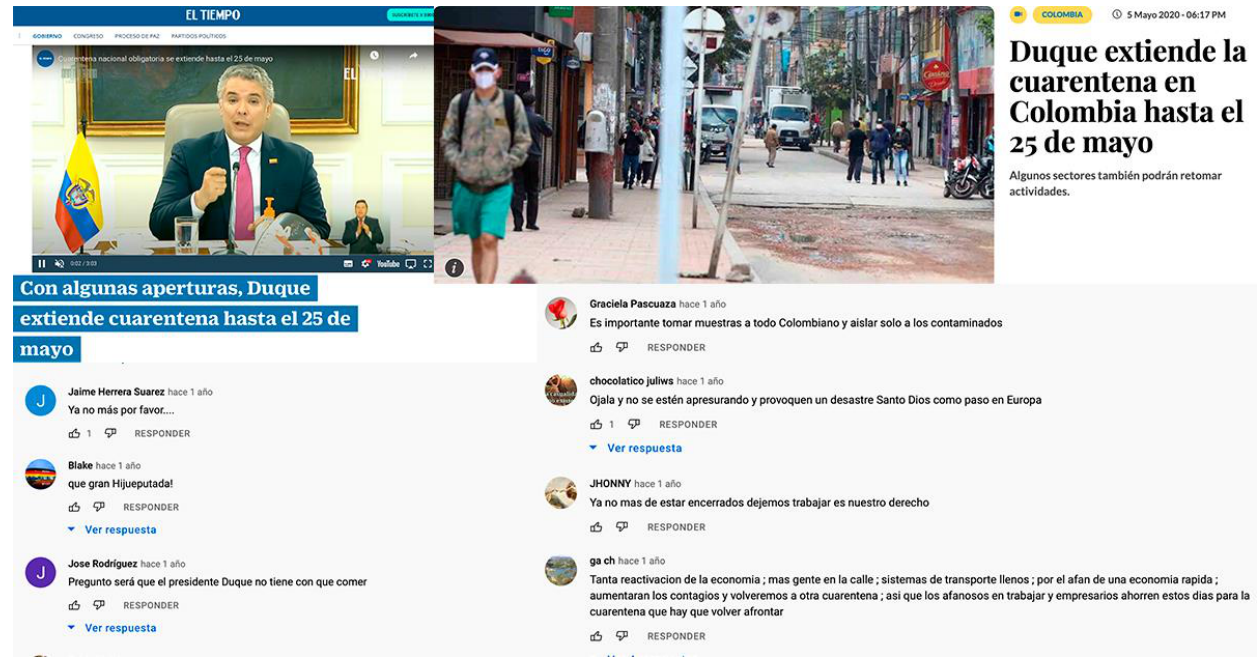
Figure 4. Short-term messages and user reaction. Source: prepared by the author with images extracted from digital platforms.